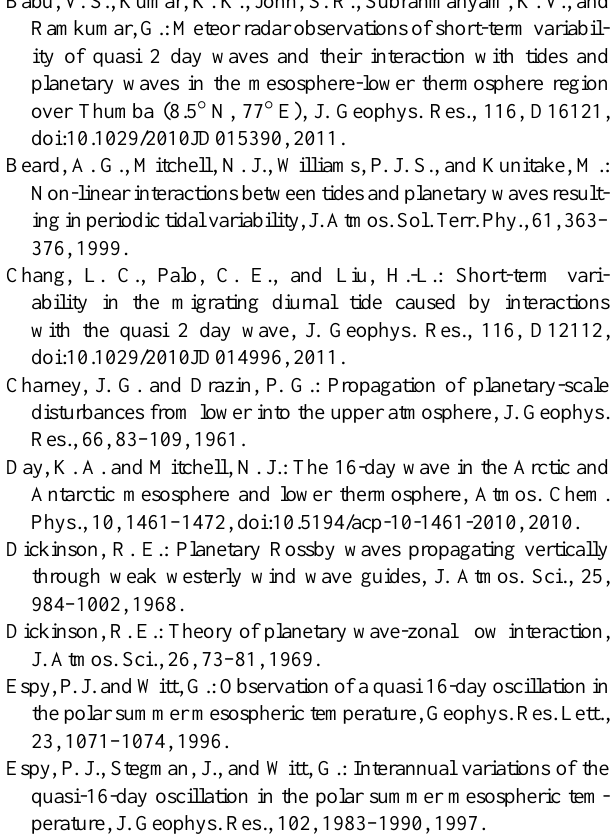
Fig. 7. Diurnal tide derived from band-pass filter with high and low cut-off frequencies corresponding to periods at 21.33 and